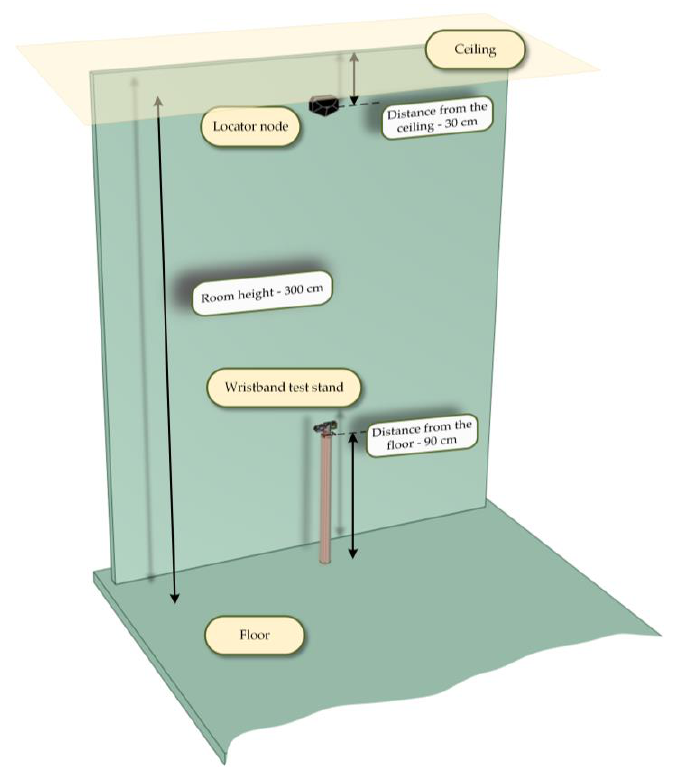
Figure 4. Location of the wristband ( PC01 , … , PC15 ) and its position relative to the locator nodes ( LocC1 , … , LocC7 ) during a series of measurements in Stage C.